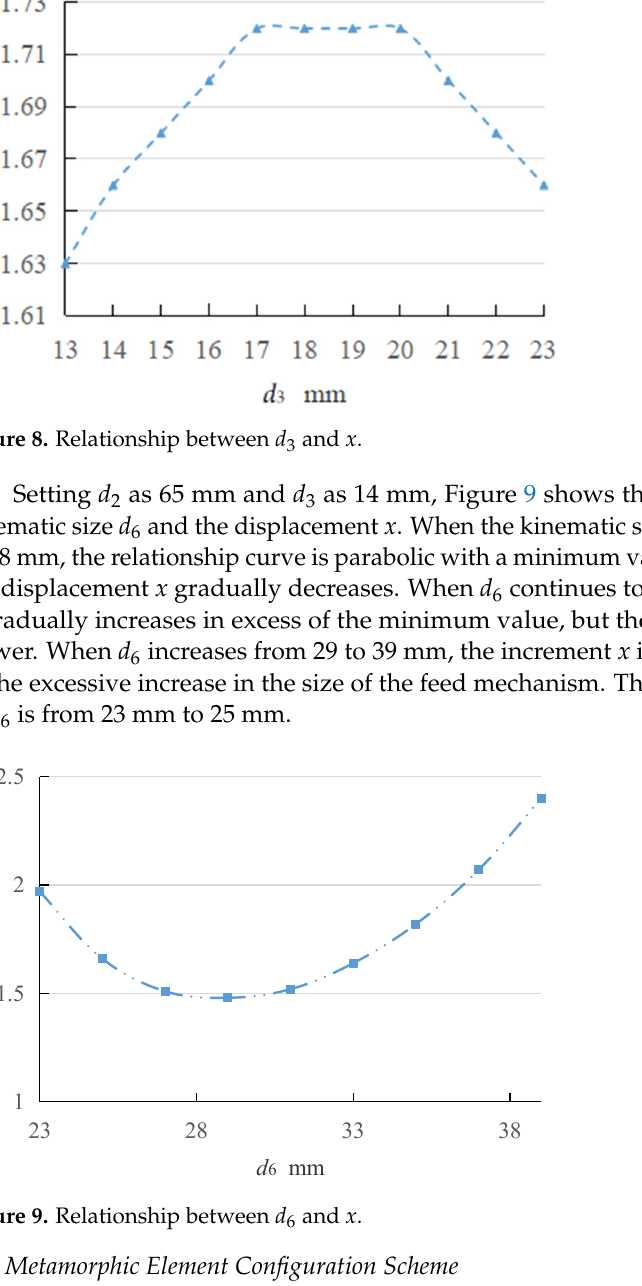
3  Figure 10. Configuration scheme set of Assur group II.